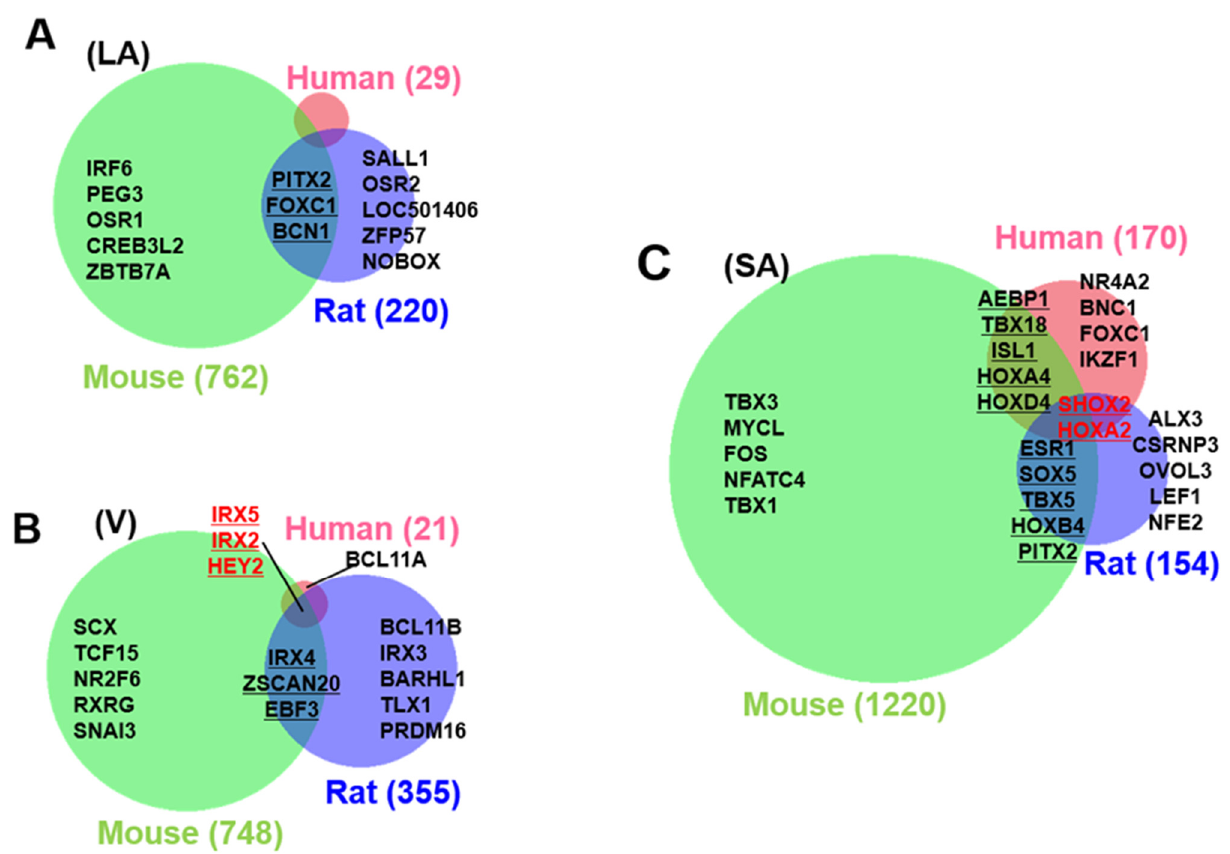
Figure 3. Cardiac region-specific genes. The number of left atrial (LA, ( A )), ventricular (V, ( B )), and sinoatrial node (SA, ( C )) specific genes selected based on SPM values are indicated by numbers in parentheses beside the area-proportional Venn diagram. Animal species are color-coded as human (pink), mouse (green), and rat (blue). Transcription factors are shown as representatives of specific genes, with a maximum of five top-ranked transcription factors in each space. The rank is determined by the magnitude of the SPM value. Specific transcription factors that are conserved across more than two species are underlined; specific transcription factors that are conserved among the three species are shown in red.